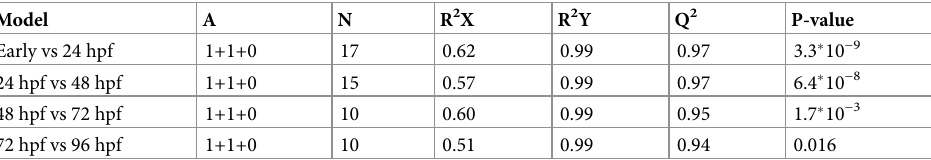
Table 2. Quality of discriminant